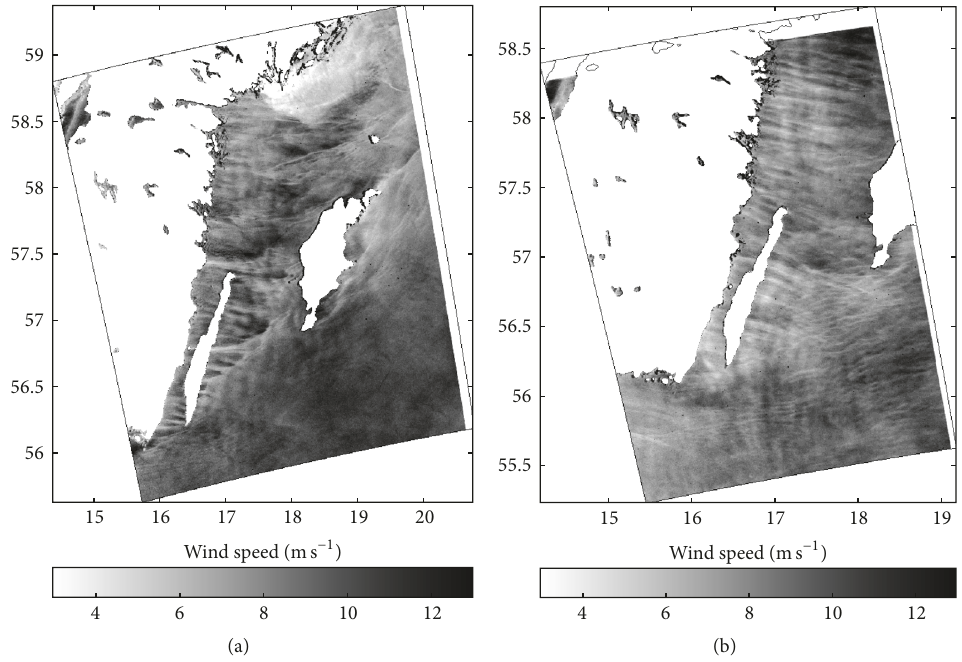
Figure 4: Processed SAR scenes acquired on (a) 17 May 2011, 2029 UTC, and (b) 25 May 2011, 2037 UTC, showing horizontal wind speed at 10m height.